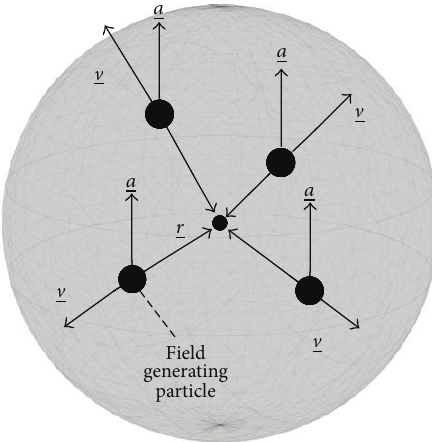
Figure 5: When the observer is not in the center of the static universe, asymmetrical inertia results.